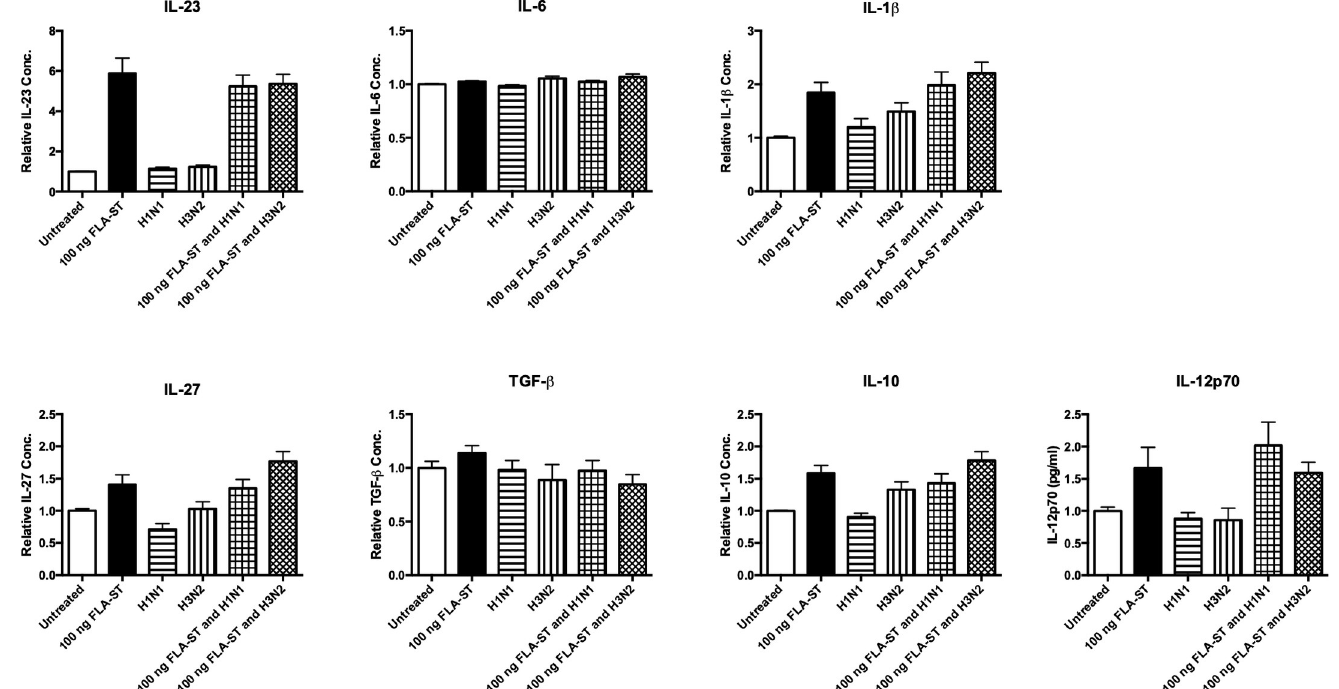
Fig 6. Live IAV does not target TLR5 pathway in human monocytes. Levels of IL-23, IL-6, IL-1 β , IL-27, TGF- β , IL-10, and IL-12p70 secreted by CD14 + cells following 24 h treatment with a TLR5 mono-agonist (FLA-ST), live H1N1 or H3N2 alone or in combination with FLA-ST (or untreated as a control) were determined by ELISA. Each column represents normalised mean cytokine levels + SEM of 3 technical repeats of each treatment in every donor. Each ELISA represents normalised results from multiple donors (n): IL-23, IL-6, IL-1 β , IL-27, TGF- β , IL-10, and IL-12p70 (n = 5). Statistical analyses were performed to compare cytokine levels in cells treated with FLA-ST versus cells exposed to live H1N1 or H3N2 in combination with FLA-ST by fitting a One-Way ANOVA to the data and using a Sidak test to adjust for multiple testing.